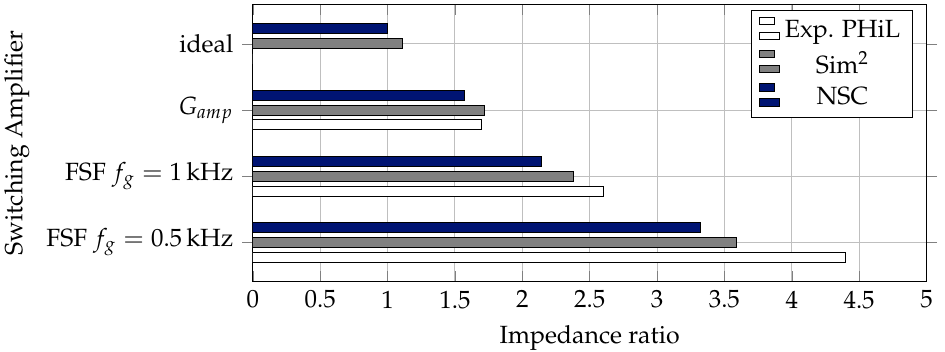
Figure 20. Impedance ratio as stability limit for analysis with a switching inverter.